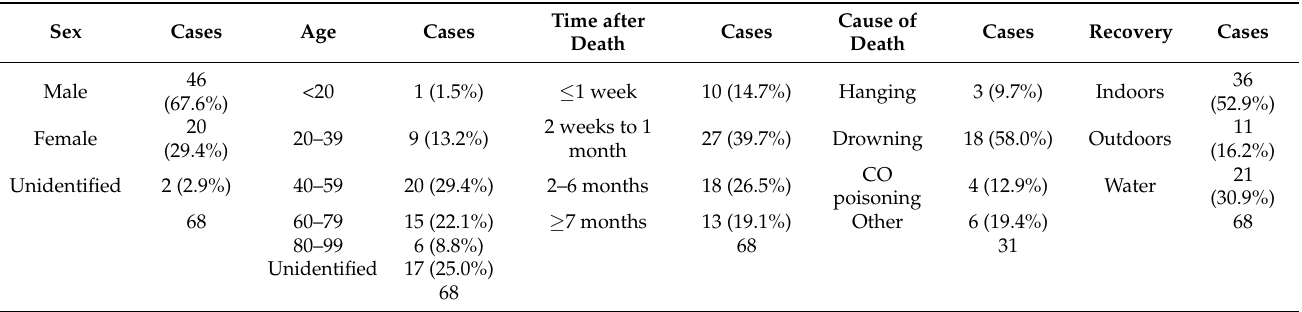
Table 1. Sixty-eight cases of pink teeth classified according to sex, age, time after death, cause of death, and place of